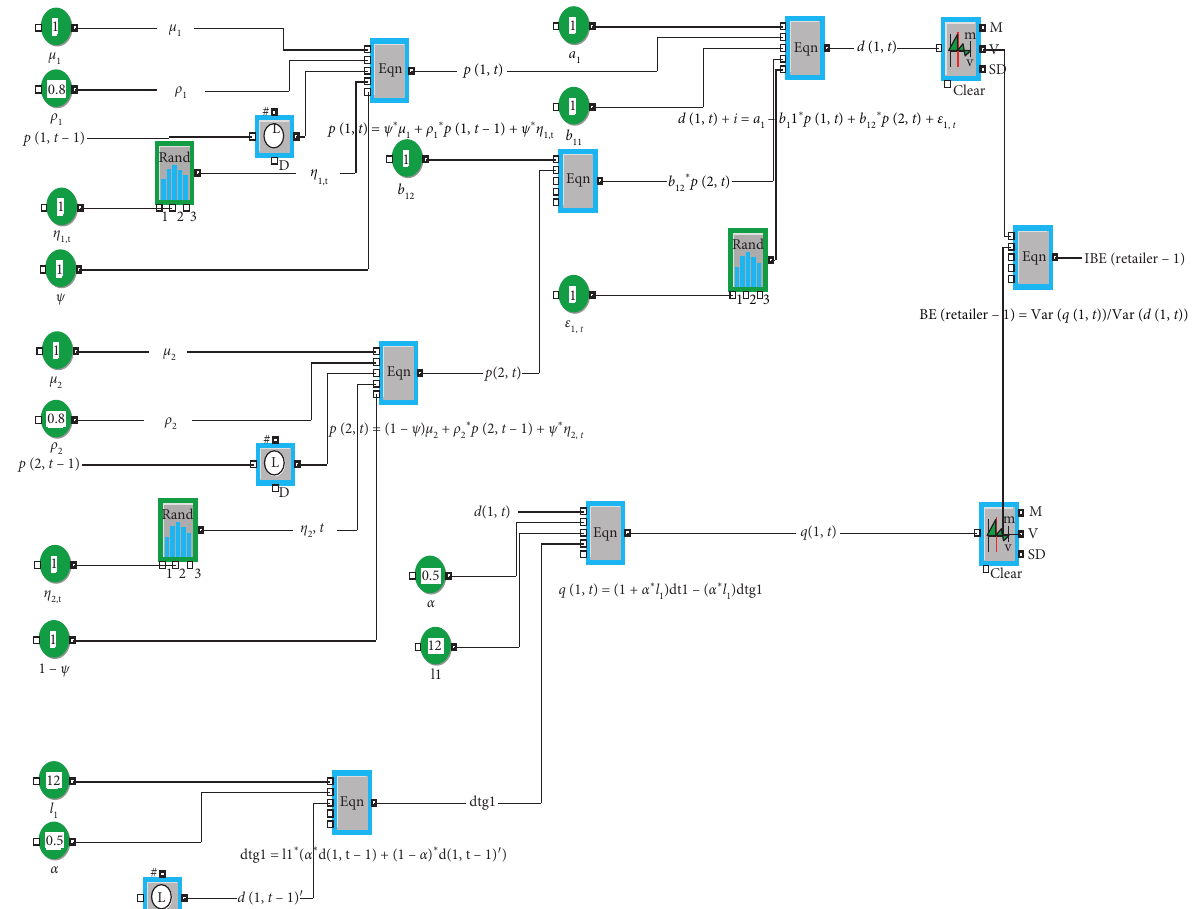
Figure 3: The simulation model of the bullwhip effect based on the ES